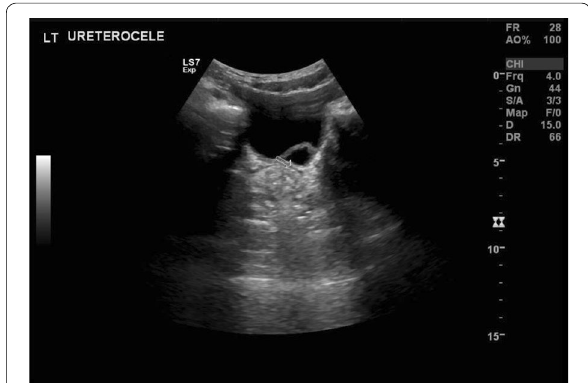
Fig. 1 Ultrasound image of bladder showing the intravesical ureterocoele (arrow)